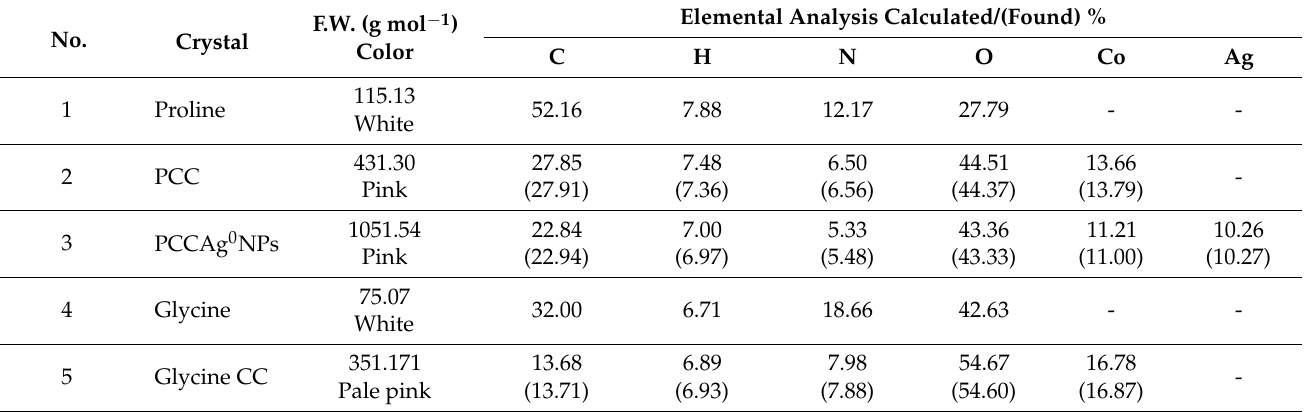
Table 2. Analytical and physical data of